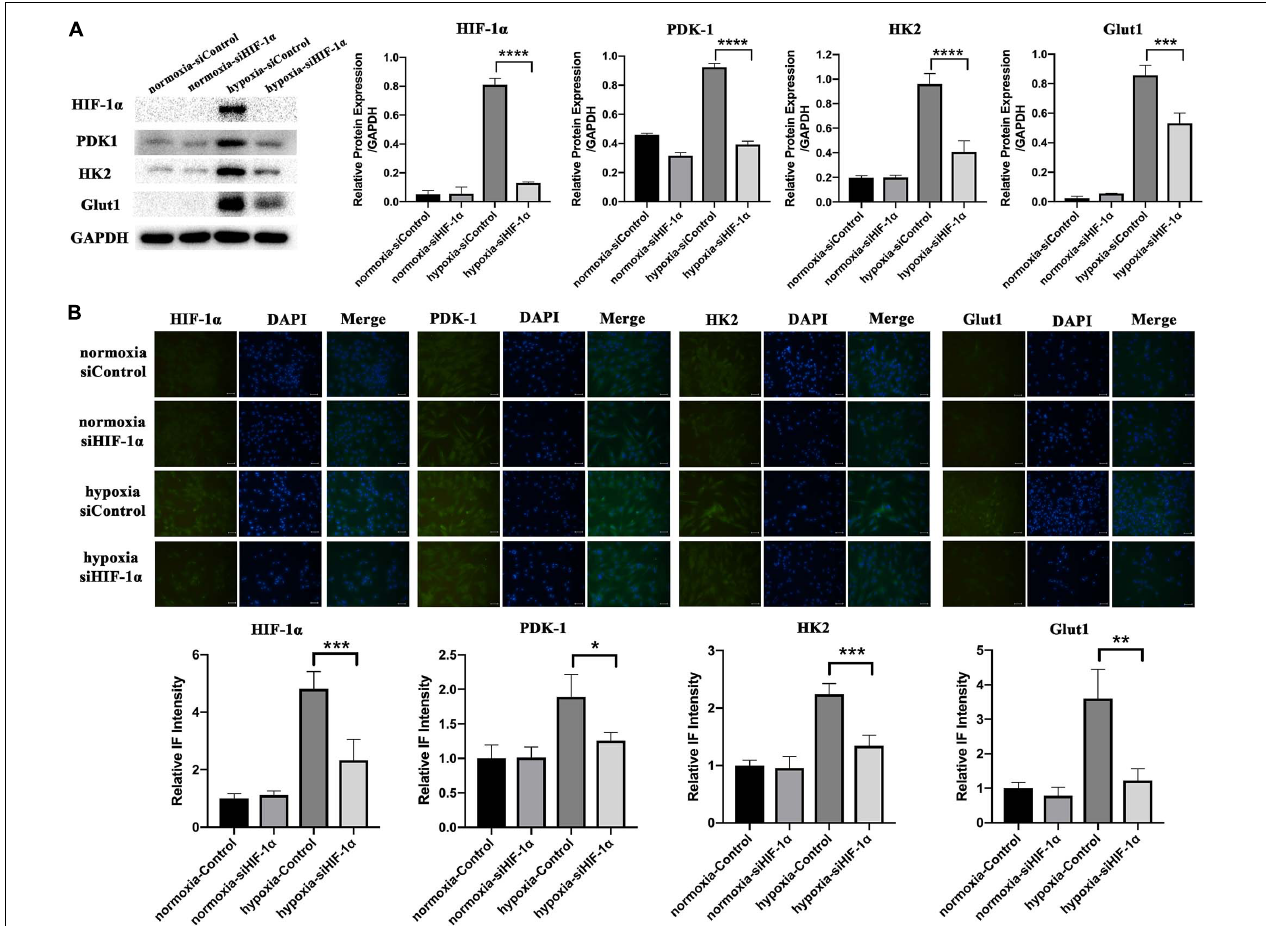
FIGURE 5 | Silencing of HIF-1 α suppressed the expression of proteins important in metabolic adaptations in vitro . (A) Protein levels of HIF-1 α , PDK1, HK2, and Glut1 in siControl and siHIF-1 α SHED in normoxia and hypoxia as shown by western blotting. (B) Immunofluorescence and relative intensity quantification for HIF-1 α , PDK1, HK2, and Glut1 in siControl and siHIF-1 α SHED in normoxia and hypoxia * p < 0.05, ** p < 0.01, *** p < 0.001, and **** p < 0.0001. Scale bar = 100 µ